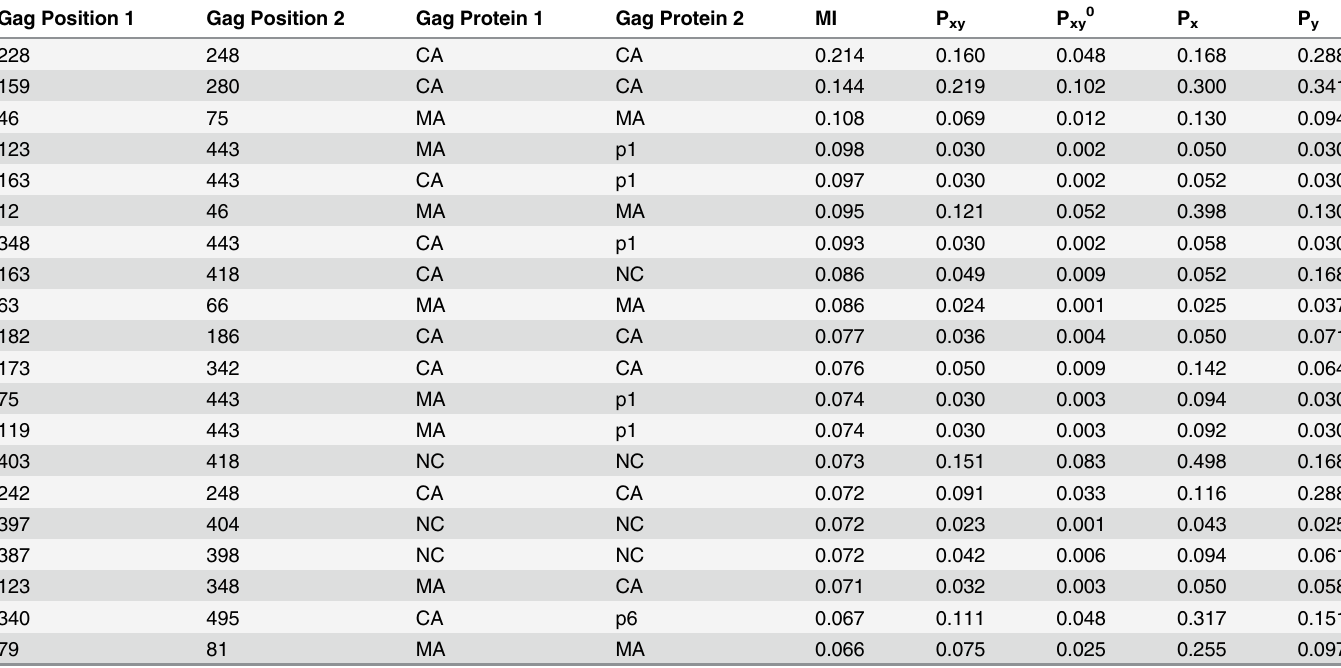
Table 4. Top 20 most strongly correlated pairs of Gag-Gag